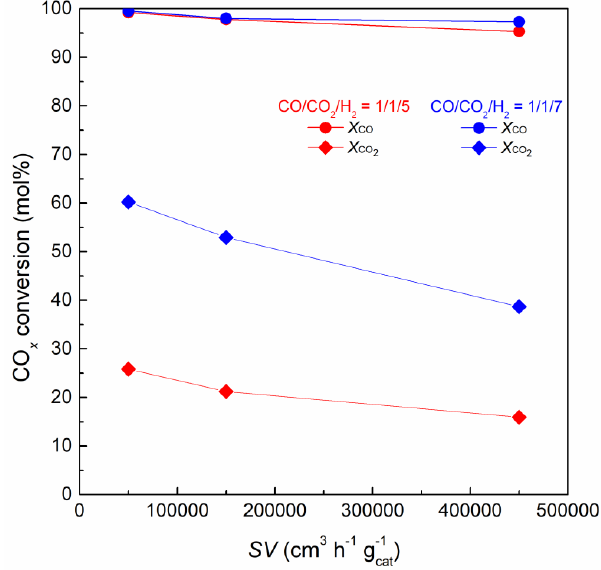
Figure 7. 6-h average CO conversion (X CO ) and CO 2 conversion (X CO2 ) vs. space velocity (SV) for Ni/Ce 0.50 Zr 0.50 O 2 in the CO x co-methanation reaction. T = 300 °C; red: CO/CO 2 /H 2 = 1/1/5; blue: CO/CO 2 /H 2 = 1/1/7.